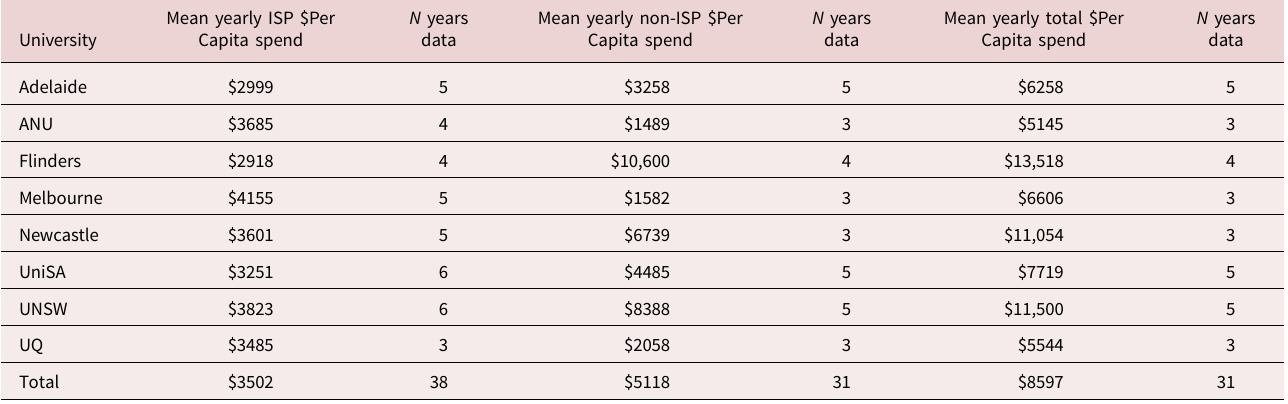
Table 2. Mean yearly spending per student a : ISP, non-ISP, Total, by participating university 2009 – 2015 Mean yearly ISP $Per University Capita